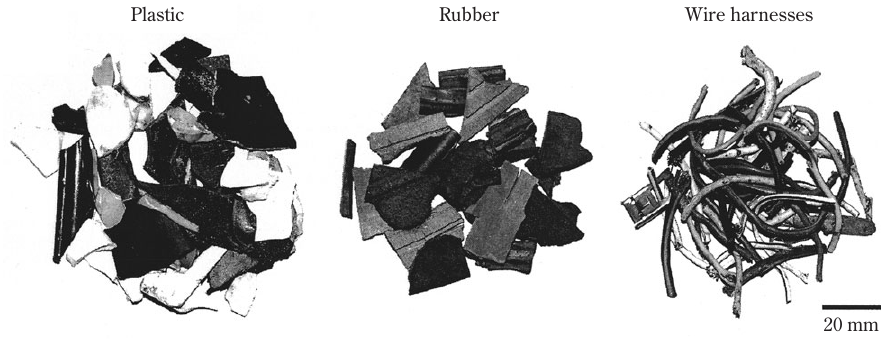
Fig. 1 Photographs of each constituent of the approximately 21 g of automobile shredder